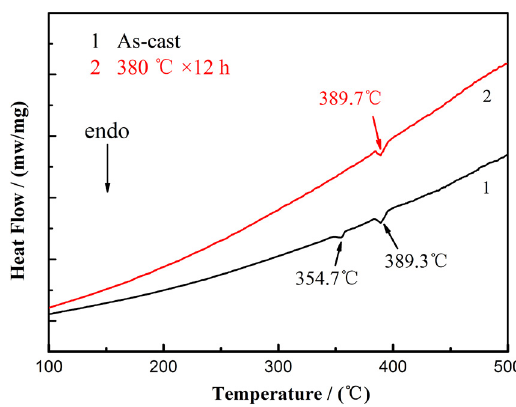
Figure 4. DSC curves of as-cast and homogenized (380 ºC × 12 h) alloys.